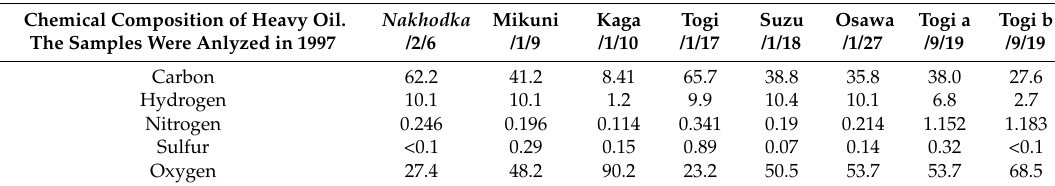
Table A3. The initial composition of heavy oil spilled from the Nakhodka oil tanker anlyzed by CHNS chemical analyzer (FISONS) (wt %) [3]. Chemical Composition of Heavy Oil. The Samples Were Anlyzed in 1997